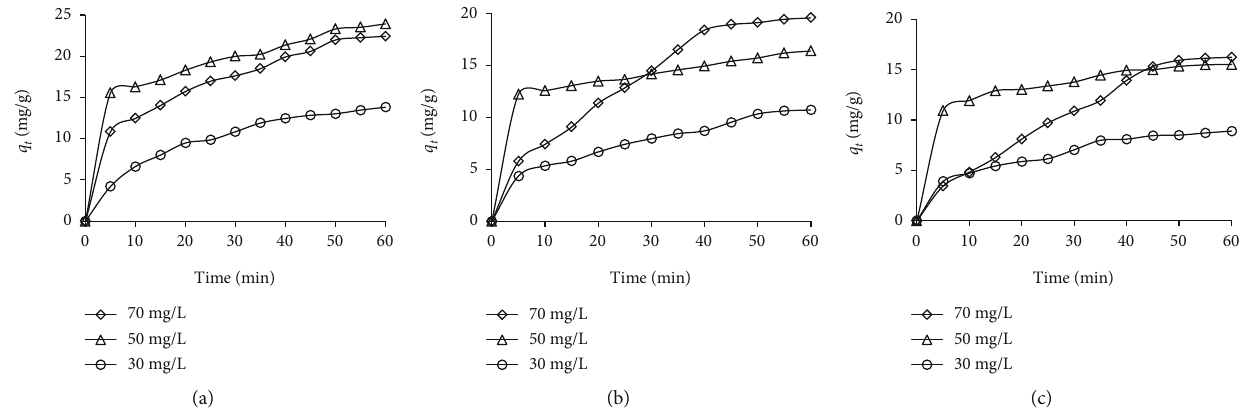
Figure 12: E ff ect of contact time on (a) lead (II), (b) Cr (III), and (c) Cd (II) adsorption at di ff erent initial feed concentration; solution: pH 5; and temperature: 25 ° C.